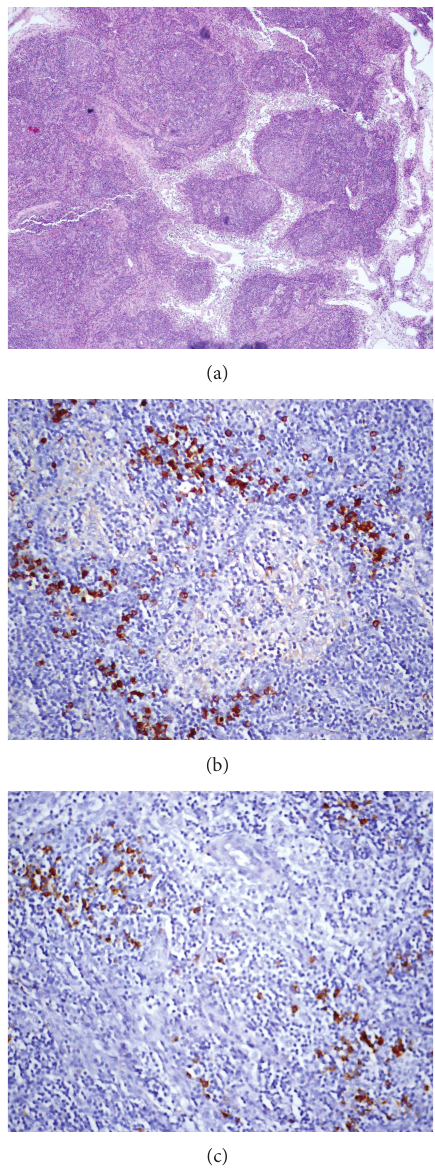
Figure 2: Mediastinal mass biopsy showed reactive lymph nodes presenting follicular hyperplasia with germinal centers and plasma- cytic infiltrate ((a) H&E stain, 40x; (b) immunohistochemical stain for IgG, 400x; (c) immunohistochemical stain for IgG4,